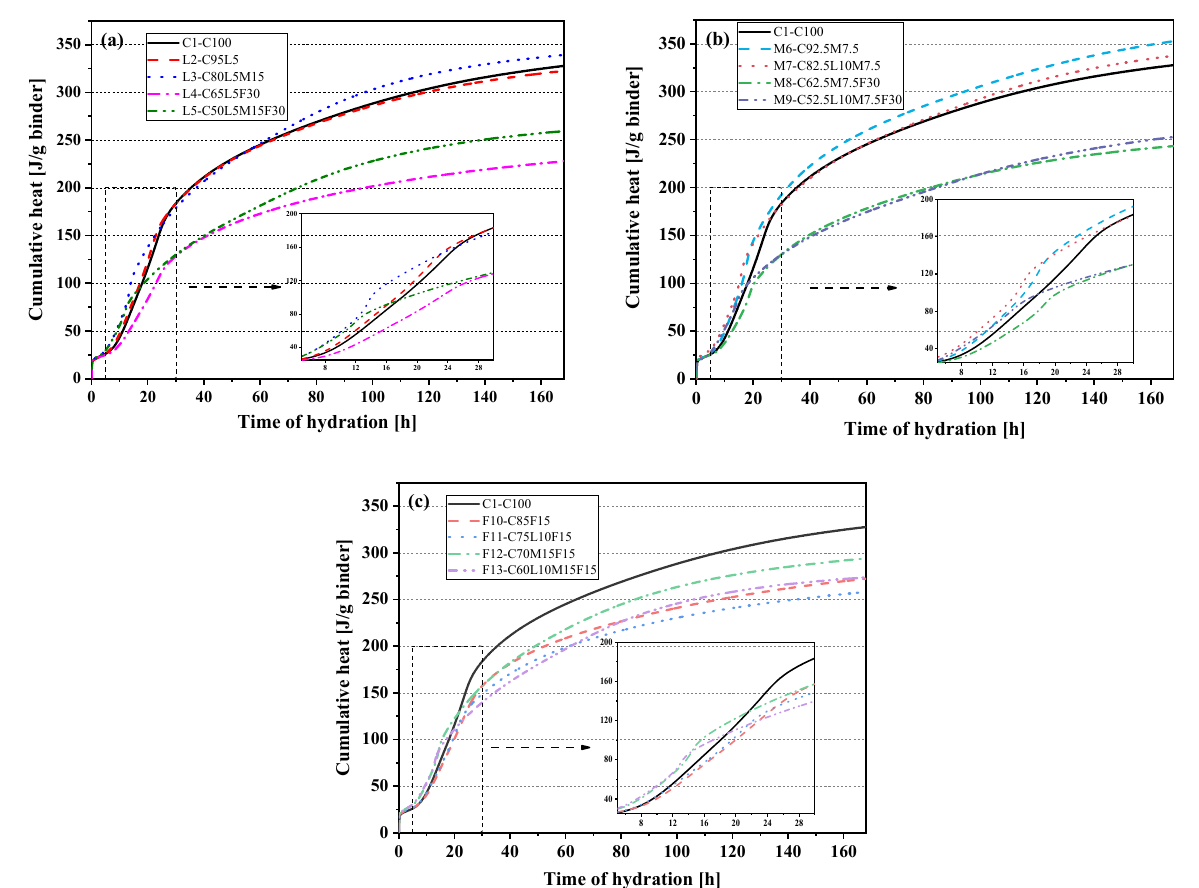
Figure 4. Cumulative heat of hydration: ( a ) the control specimen and LS system; ( b ) the control specimen and MK system; ( c ) the control specimen and FA system.